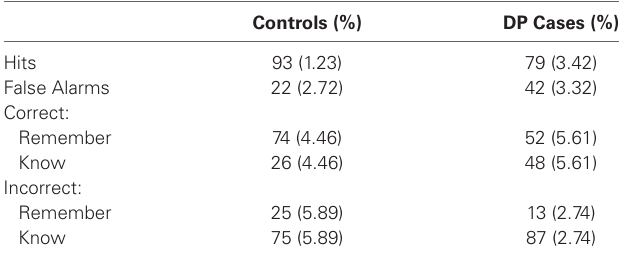
Table 2 | Mean accuracy and proportion of correct and incorrect responses (with standard errors).